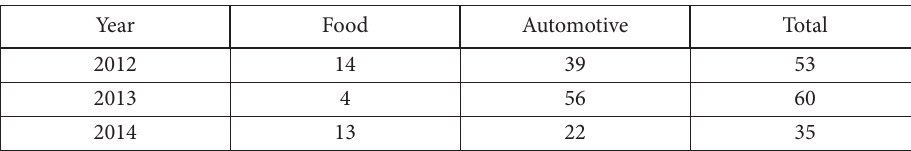
Table 1. Distribution of event